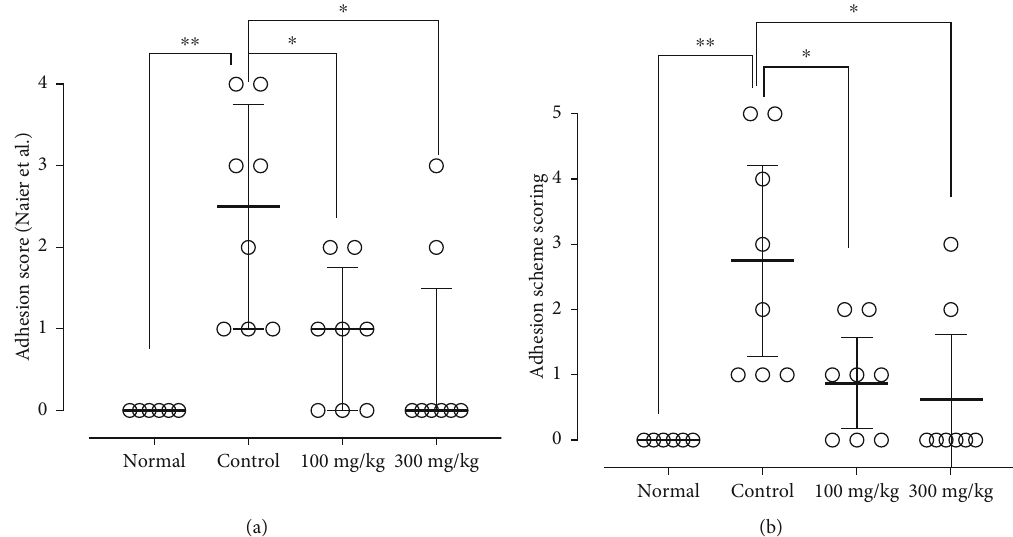
Figure 3: The e ff ects of di ff erent doses of PO on adhesion scores evaluated by Naier et al. (a) and Adhesion Scoring Scheme (b) scoring systems; data were presented as median ± interquartilerange , IQR ( n = 8 for all groups except normal as 6). ∗ P < 0 : 05 and ∗∗ P < 0 : 01 .